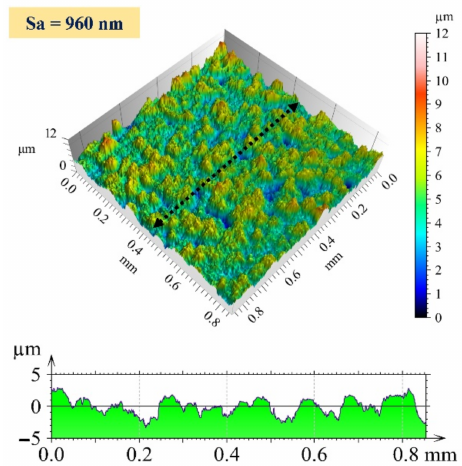
Figure 6. Three-dimensional surface profile and 2D profile curve (along the marked line in 3D image) of as-plated